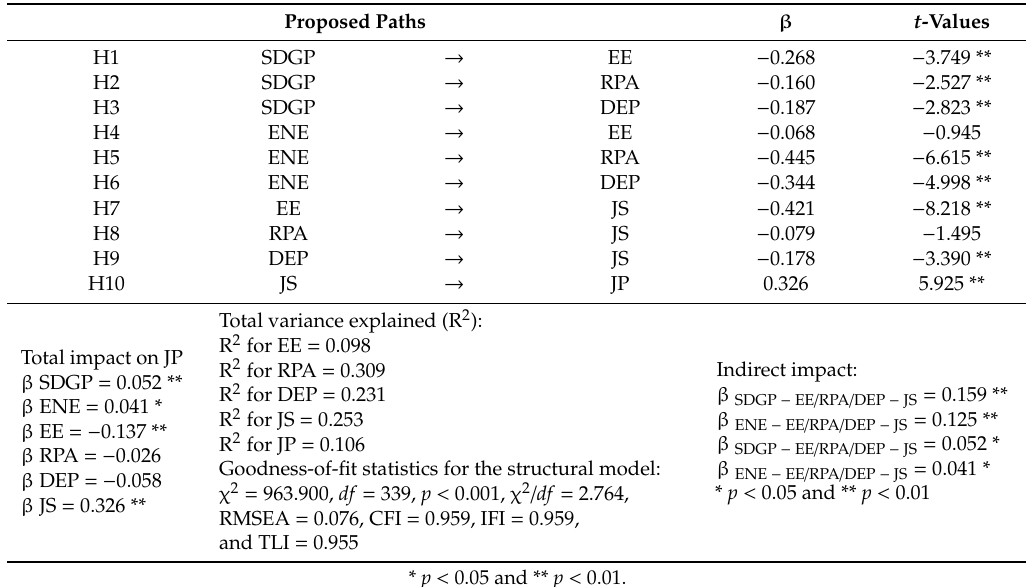
Table 2. Coe ffi cient, t-value, total impact, indirect impact, R 2 , and hypotheses testing ( n = 309). Proposed Paths β t -Values H1 SDGP → EE − 0.268